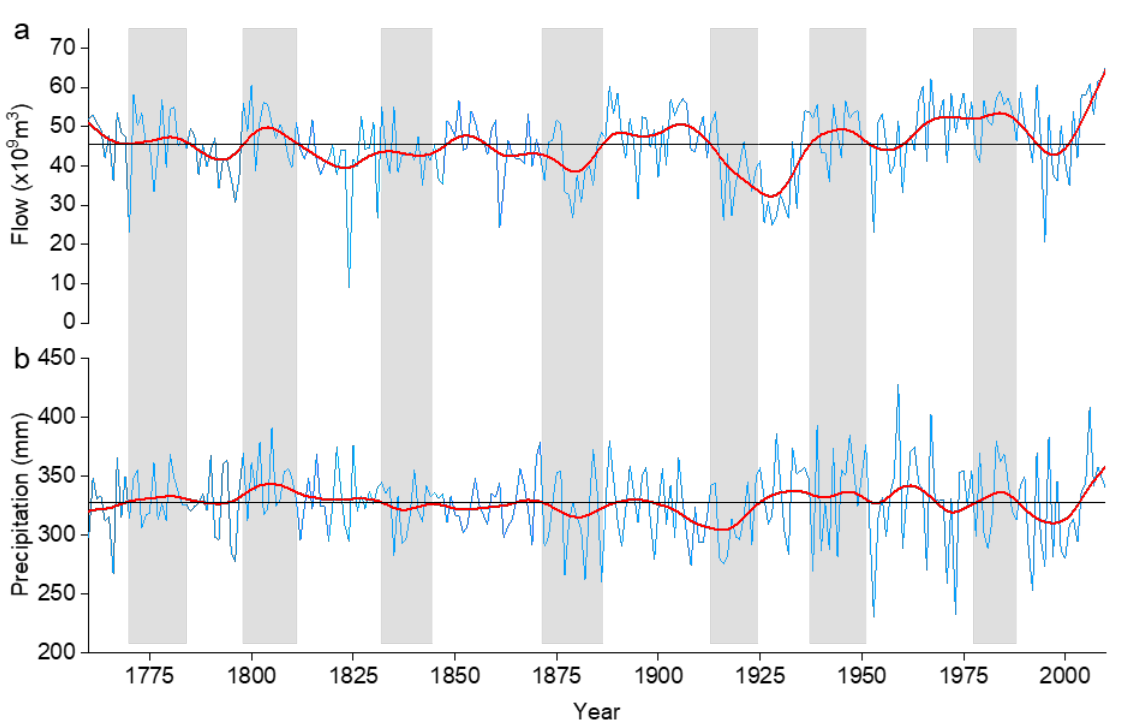
Figure 7. Comparison between the October–September flow reconstruction of middle Yellow River ( a ) and August–June total precipitation ( b ) over the 1760–2010 period. All series were smoothed with a 21-year low-pass filter to emphasize decadal fluctuations. The shadow means the common wet/dry periods.